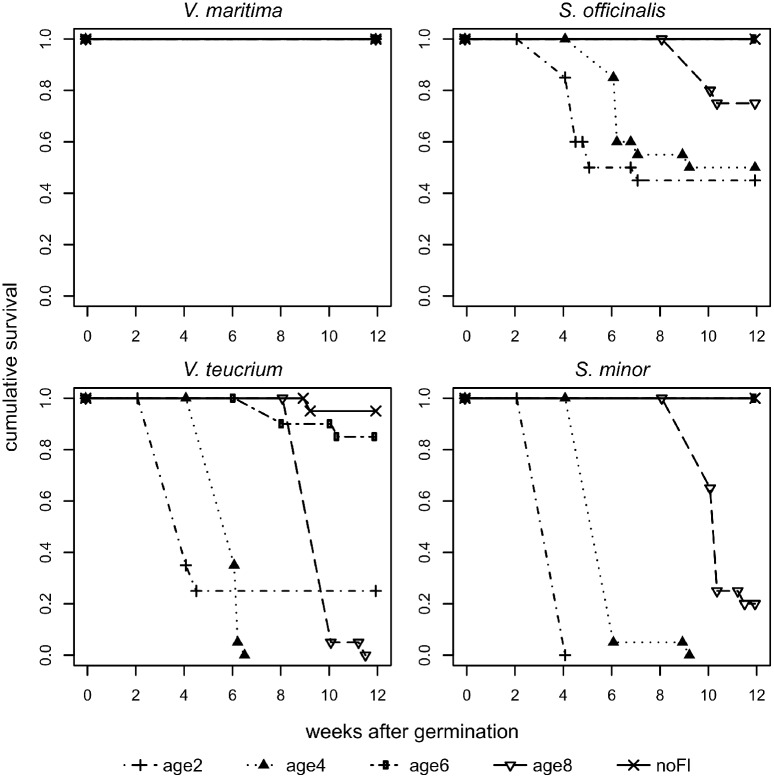
Effects of a 2-week flooding treatment on survival of four floodplain meadow plant species.Cumulative survival of Veronica maritima L., Veronica teucrium L., Sanguisorba officinalis L., and Sanguisorba minor Scop. after a 2-week flooding treatment, starting 2, 4, 6, and 8 weeks, respectively, after germination (age2-age8), and a control group with no flooding (noFl). age2, dot-dashed line & plus; age4, dotted line & filled triangle point up; age6, two-dashed line & circle; age8, long-dashed line & triangle point down; noFl, solid line & cross.